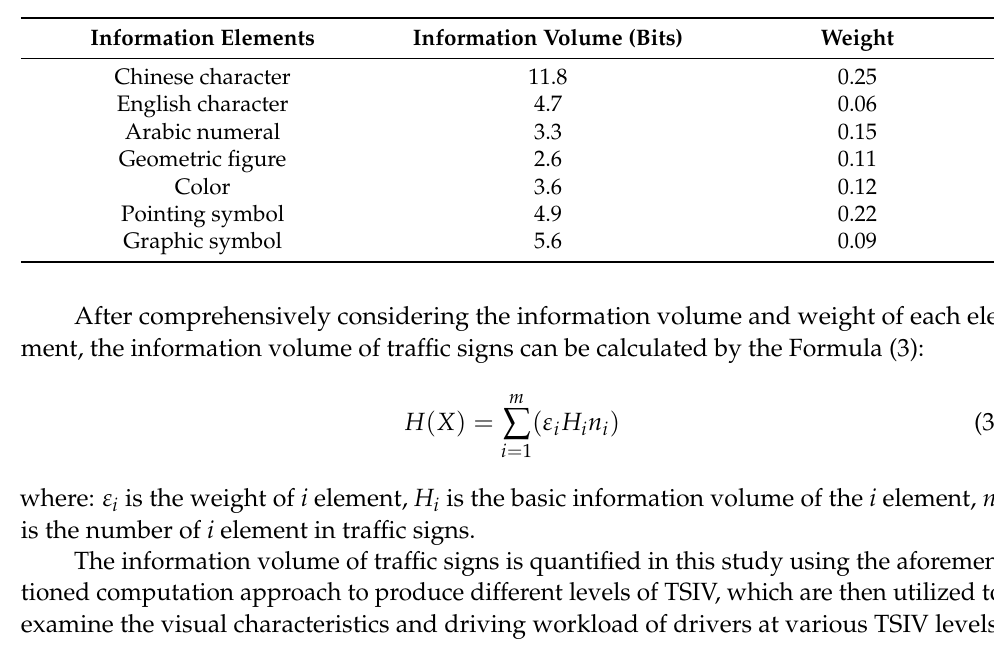
Table 1. Information volume and weight of each traffic sign information